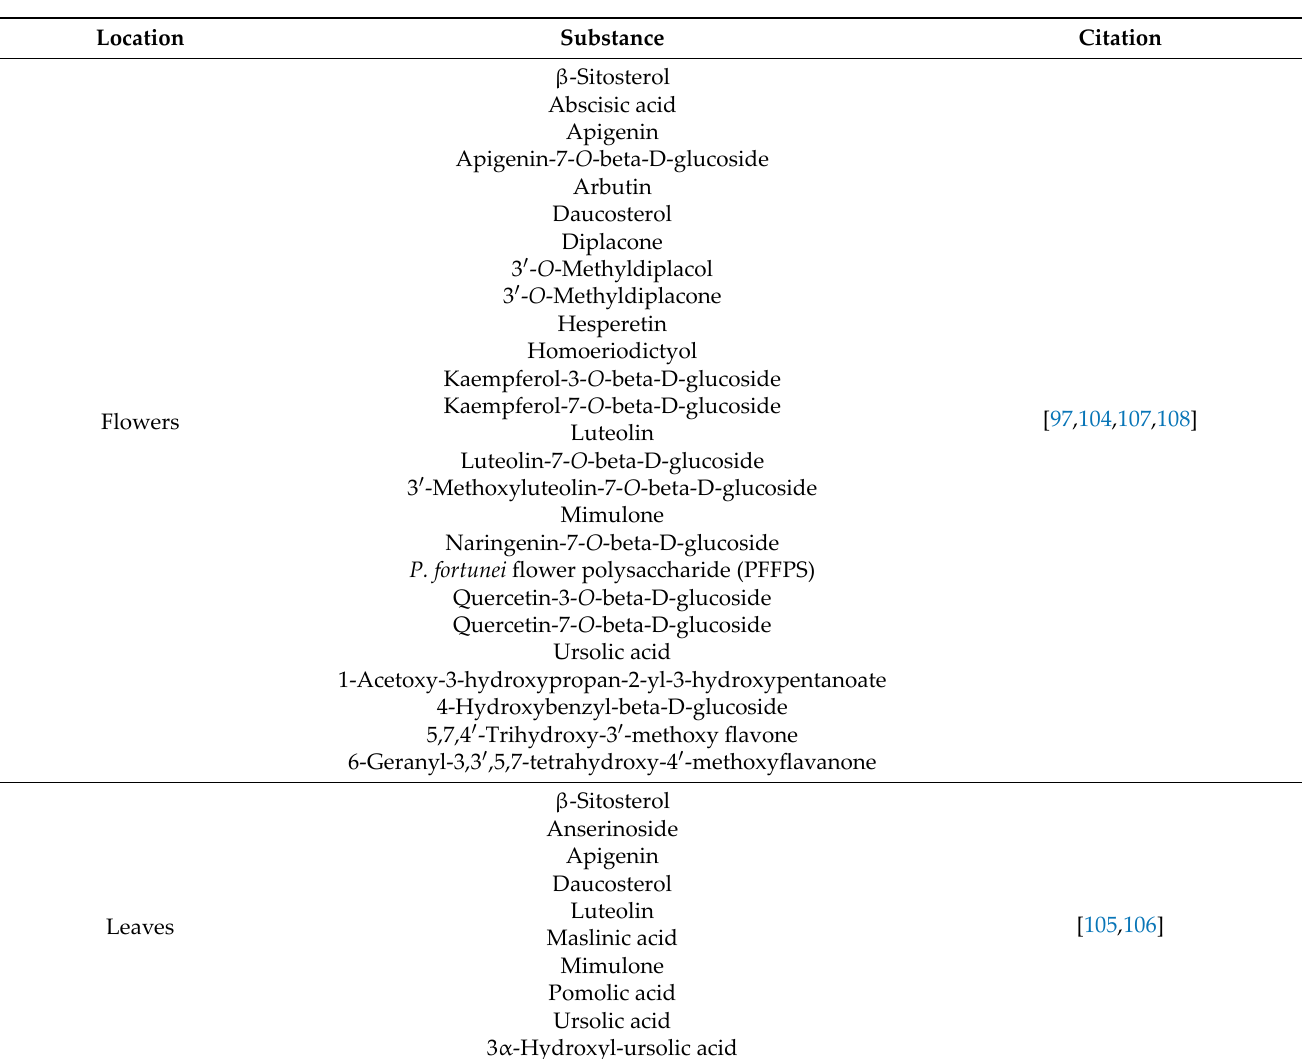
Table 3. Substances isolated from flowers and leaves of P. fortunei